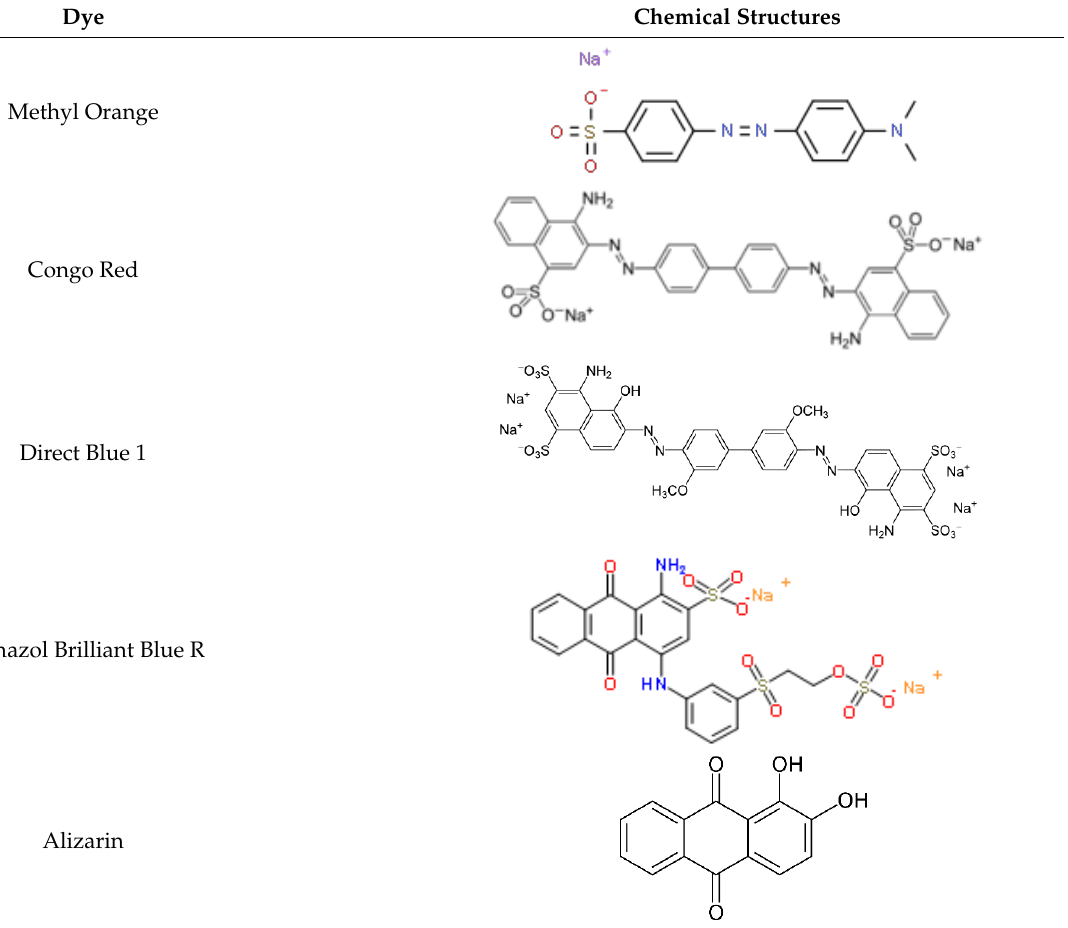
Figure 1. Major textile exporters in the world in 2018 [10]. Table 1. Chemical structures of dyes. Dye Chemical Structures Methyl Orange